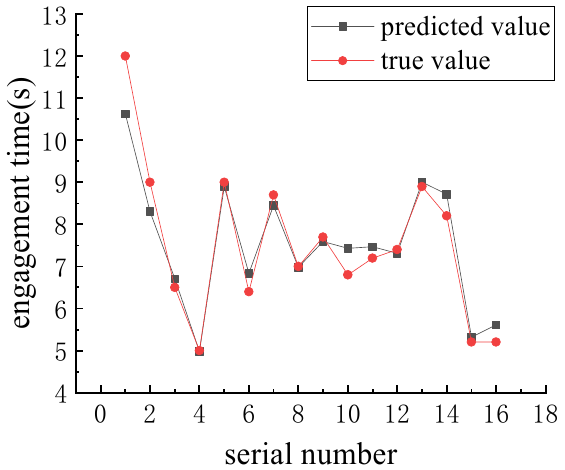
Figure 27. Engagement time SVR prediction results.